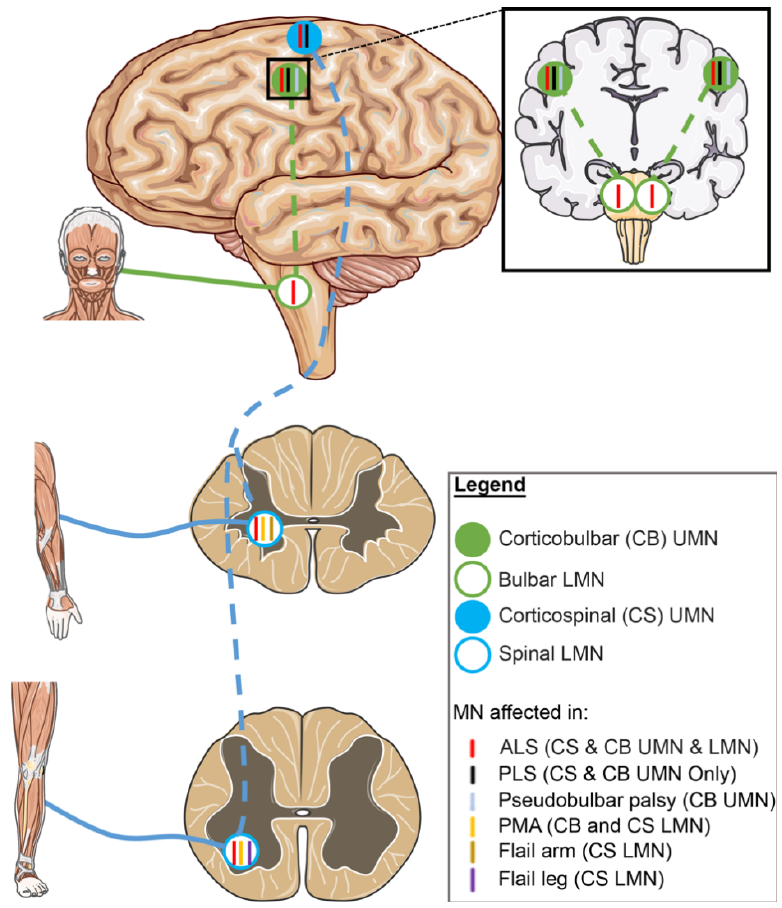
Figure 2. The role of upper and lower motor neurons in different ALS variants. ALS is a disease with high variability in clinical phenotype. “Classic ALS” patients will present with signs of both UMN and LMN degeneration. However, patients with progressive muscular atrophy (PMA) and primary lateral sclerosis (PLS) present with LMN-predominant or UMN-predominant signs, respectively. LMN-predominant patients also include flail-arm syndrome and flail-leg syndrome ALS variants where LMN signs are present in upper or lower limbs, respectively. ALS patients might present symptoms in bulbar-innervated muscles, if UMN signs are predominant, patients are diagnosed with pseudobulbar-palsy. Blue colour circles indicate motor neurons of the corticospinal tract. Green colour circles indicate motor neurons of the corticobulbar tract. Solid circles indicate UMNs and open circles indicate LMNs. Colour of ticks corresponds to colour of variant label and tick location indicates the motor neuron populations affected. ALS: amyotrophic lateral sclerosis. PLS: primary lateral sclerosis. PMA: progressive muscular atrophy. CS: corticospinal. CB: corticobulbar.